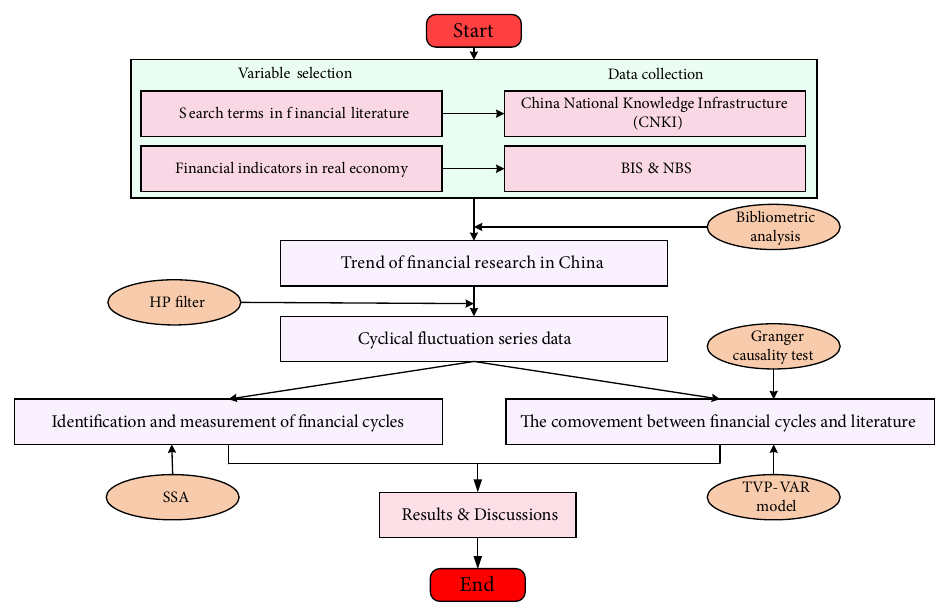
Figure 1. The research framework and process of this study (source: authors’ own